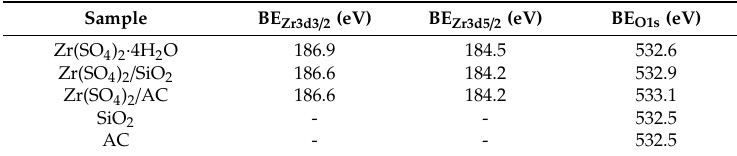
Table 3. Binding energies of the Zr3d and O1s regions of various